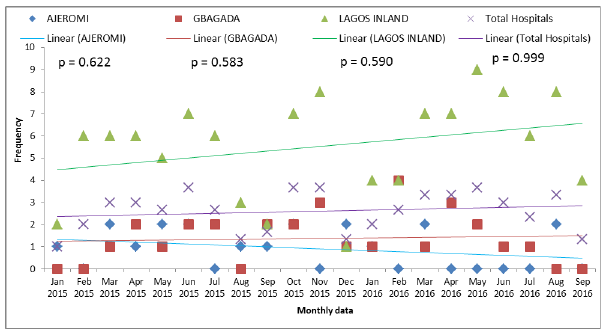
Fig 2. Trends plot of maternal mortality in Lagos state. An increase in MMR in LIMH ( χ 2 = 17.97; df = 20; p = 0.590), in GGH (( χ 2 = 18.07; df = 20; p = 0.583) while a decreasein MMR was observedin AGH ( χ 2 = 17.47; df = 20 p = 0.622). However, this observation was not significantat p < 0.05.